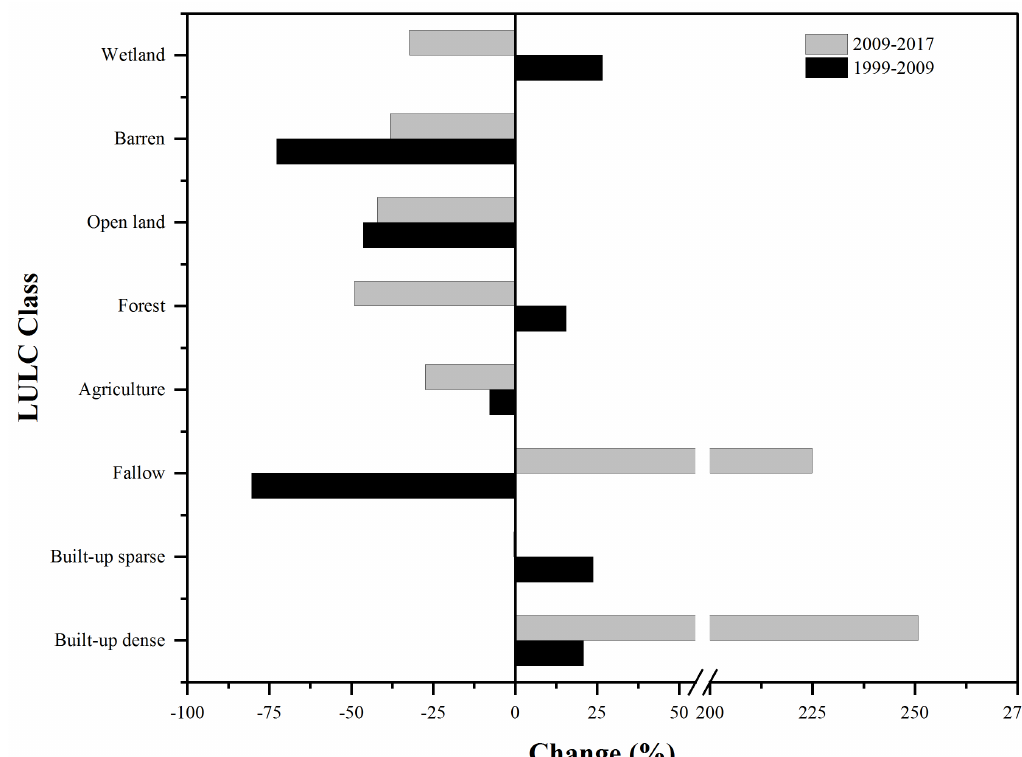
Figure 5. LULC changes in di ff erent classes for the city area (CA) in T 1 and T 2